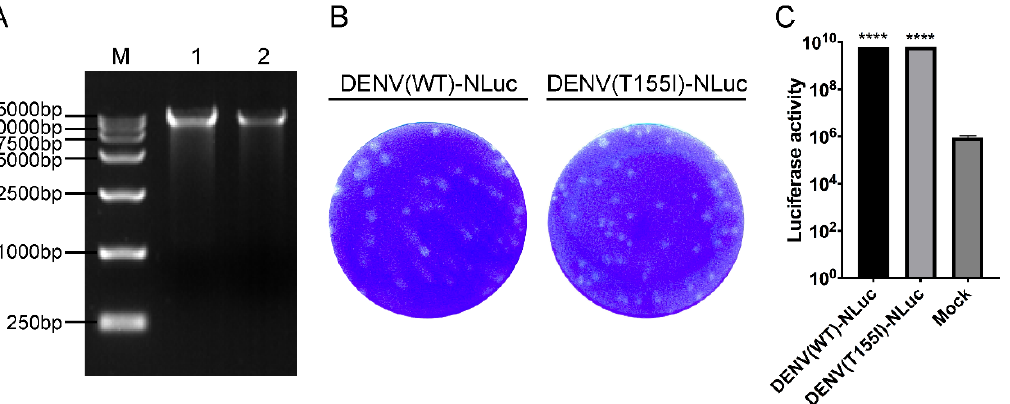
Figure 2. Construction and biological properties of DENV(WT)-NLuc and DENV(T155I)-NLuc. ( A ) DENV-NLuc full-length linear sequence ligated in vitro with T4 DNA ligase. M: DL15000 marker; 1: DENV(WT)-NLuc linkage products; 2: DENV(T155I)-NLuc linkage products. ( B ) Plaque morphol- ogy of DENV with the NanoLuc reporter gene. The dilution factor was 10 − 4 -fold. ( C ) Luciferase activity of Vero cells after infection of reporter DENV. ****, p ≤ 0.0001 compared with Vero cells in the mock